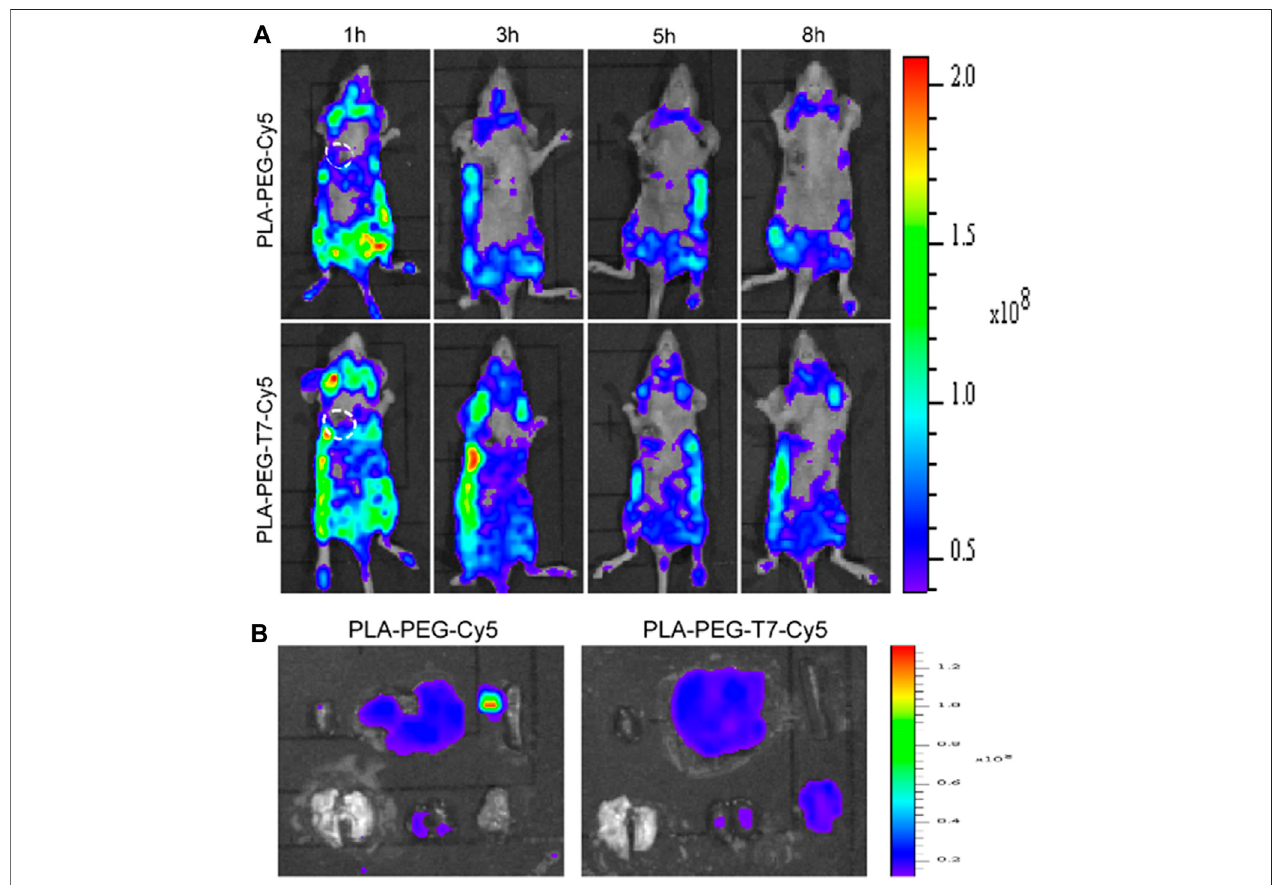
FIGURE 4 | (A) In vivo fl uorescence images of LN229 tumor-bearing nude mice at different time points. (B) Ex vivo fl uorescence imaging of various organs and tumors of LN229 tumor-bearing mice after injection.